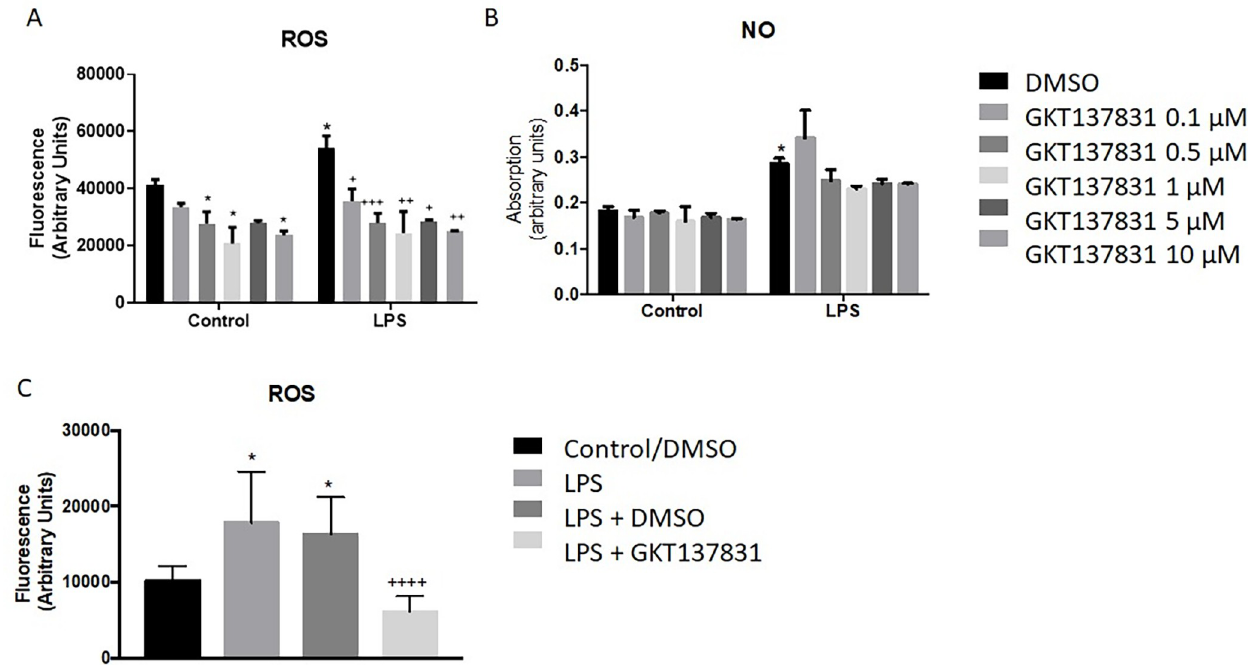
Fig 5. GKT137831 treatment in microglia reduces LPS induced ROS in a dose-dependent fashion, but has no effect in NO release. BV2 microglial cells were stimulated with LPS and treated with the NOX inhibitor GKT137831 one hour after stimulation. 24 hours after ROS and NO production was assessed using DCF and Greiss assay, respectively. Microglia show a dose dependent significant decrease of ROS release in GKT137831 treated compared to control or LPS alone (A). NO shows no significant reduction with any concentration of GKT137831 (B) ROS production decrease in response to GKT137831 treatment was confirmed in primary microglial cells (C). N = 3. � p < 0.05 compared to control, + p < 0.05, ++ p < 0.01, +++ p < 0.001 compared to LPS, using Two-Way ANOVA (A)(B) and One-Way ANOVA (C) with Dunnett’s Multiple Comparison post-test. Bars represent mean score +/-